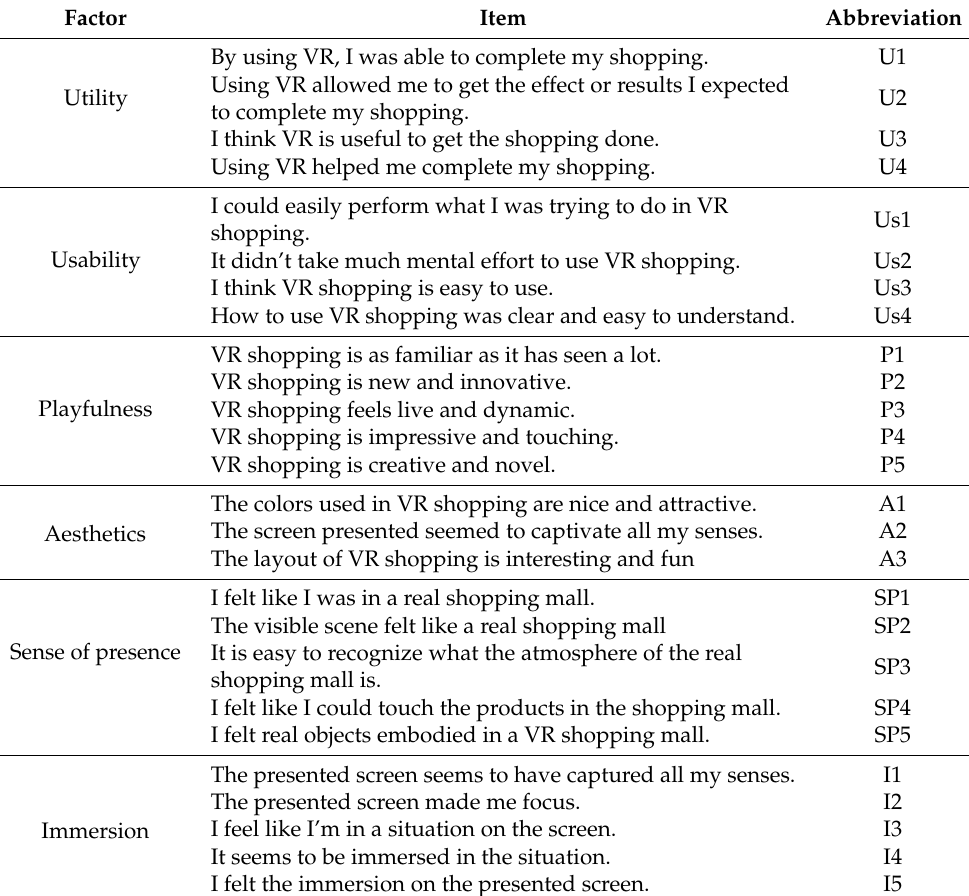
Table 2. Survey factors for each